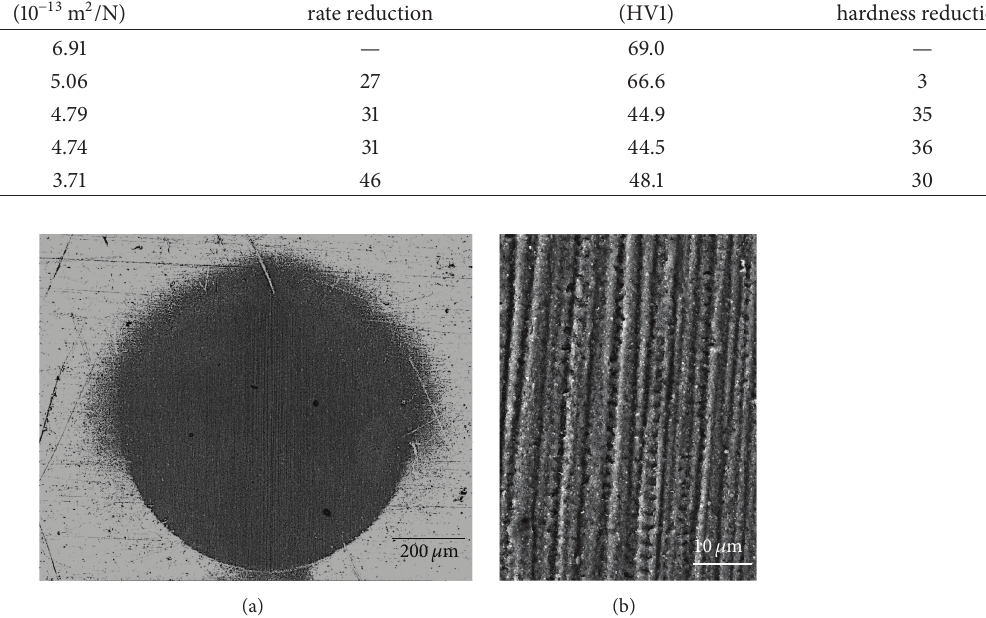
Figure 4: (a) Crater in an AR specimen with continuous grooves. (b) SEM image of the grooves in the crater (AR specimen). (b) is a zoom in the crater shown in (a).